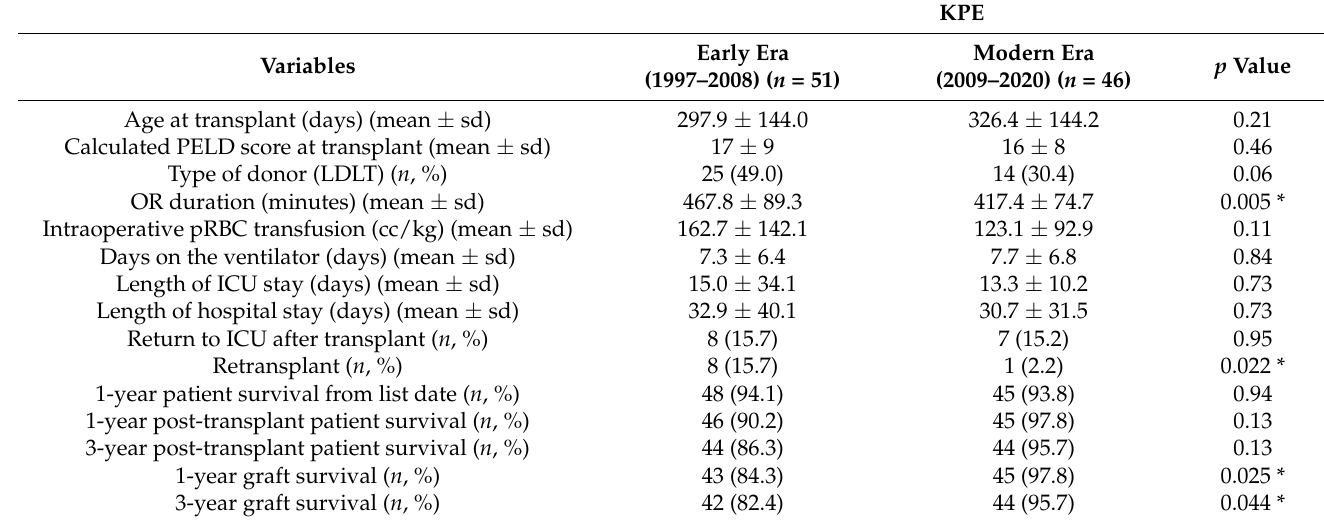
Table 6. Post-transplant comparison of patients transplanted after KPE based on era: transplant- related data and post-transplant outcomes. Legend: * represents a statistically significant